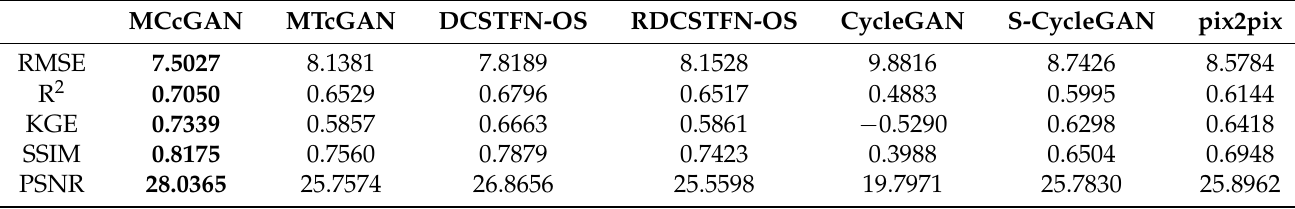
Table A1. The evaluation metrics of different methods for the red band in Area B at Time III (the bold result is the best among the different metrics).